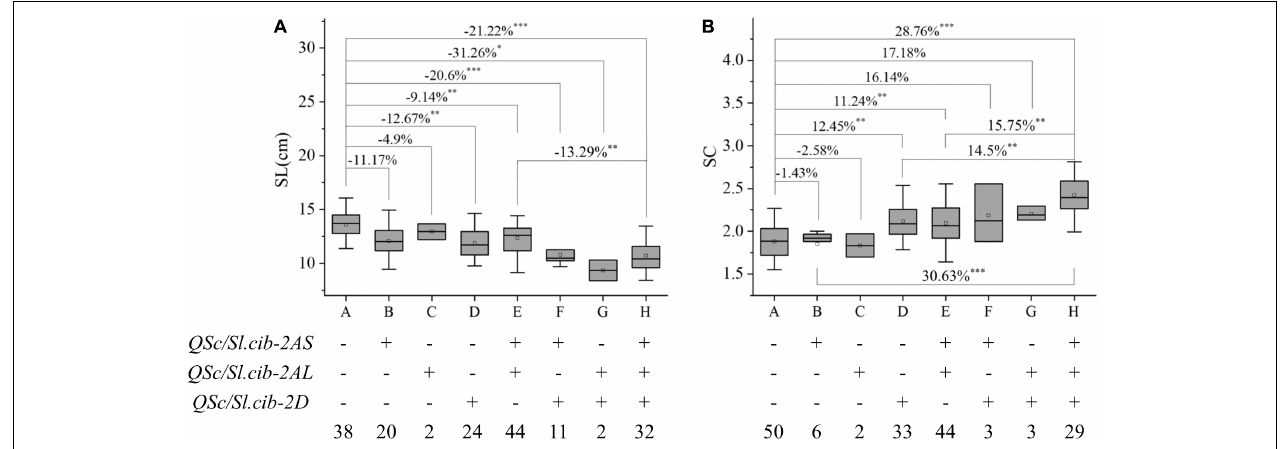
FIGURE 6 | Additive effects of three QTL on spike compactness (SC, B ) and spike length (SL, A ), respectively. Symbols + and – represent lines with and without the positive alleles for the target quantitative trait loci (QTL) based on the flanking marker of the corresponding QTL, respectively. ∗ , ∗∗ , and ∗∗∗ represent significance at P < 0.05, P < 0.01, and P < 0.001,